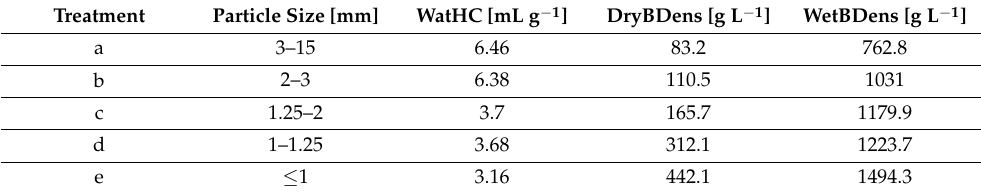
Table 3. Properties of straw fractions used to prepare the